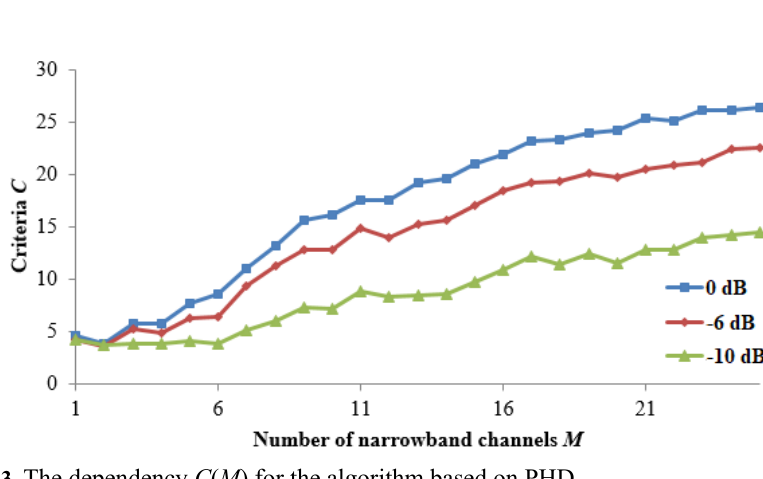
Fig. 3. The dependency C ( M ) for the algorithm based on PHD.